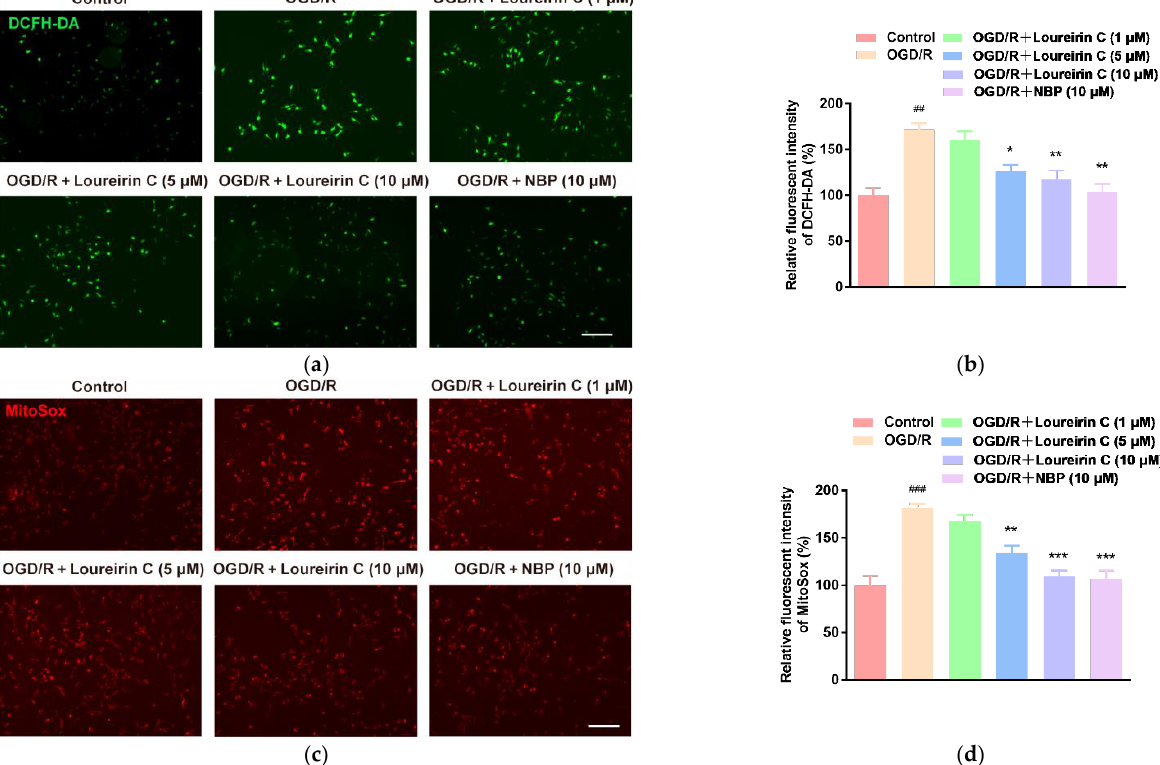
Figure 2. LC inhibits the release of ROS. ( a ) The SH-SY5Y cells with different treatments were stained with DCFH-DA (green fluorescence) and imaged by a laser scanning confocal microscopy. ( b ) Bar graph is the fluorescence intensity analyses of ( a ); ( c ) the SH-SY5Y cells with different treatments were stained with MitoSOX ™ Red and imaged by a laser scanning confocal microscopy. ( d ) Bar graph shows the fluorescence intensity analyses of ( c ) . (Data are expressed as mean ± SD ( n = 3). ### p < 0.001, ## p < 0.01 vs. Ctrl; *** p < 0.001, ** p < 0.01, * p < 0.1 vs. OGD/R group . Scale bar = 100 μm ).